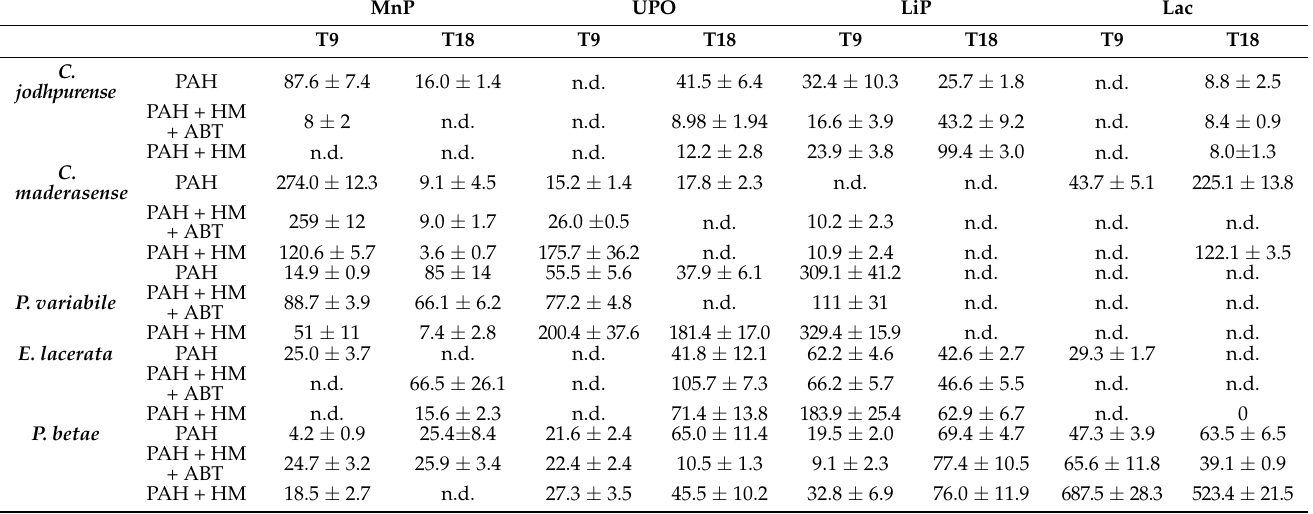
Table 1. Enzymatic activities. MnP—manganese peroxidase; UPO—unspecific peroxygenase; LiP—lignin peroxidase; Lac—Laccase, expressed as (UI) during PAH treatment after 9 and 18 days of cultivation in the absence and presence of HMs. ± Value indicates the average of tree replicates (n = 3). MnP UPO LiP